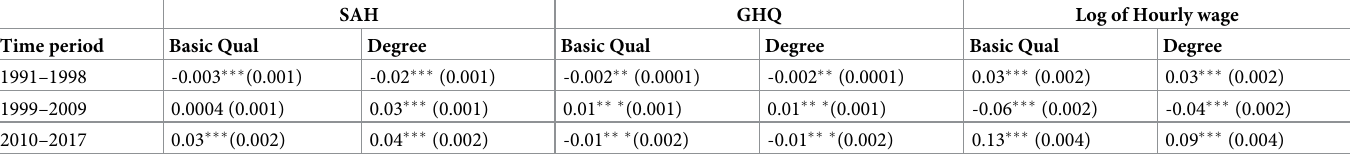
Table 3. Trends in the intergenerational correlation in SAH, GHQ and Log of hourly wage by parental educational attainment over the period 1991–2017.